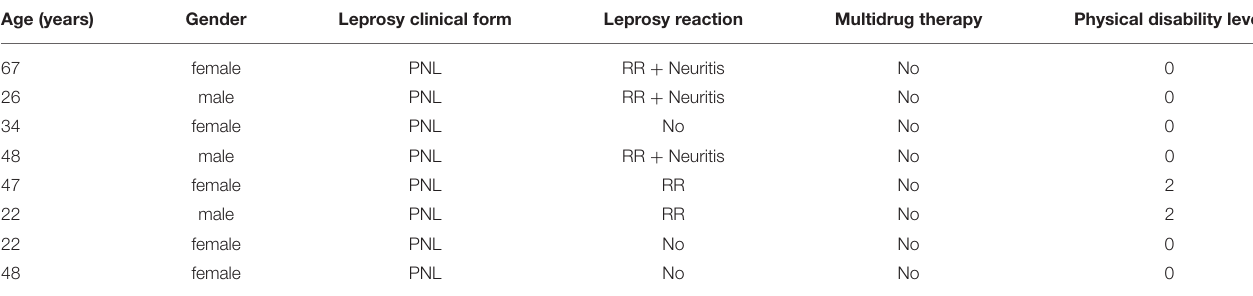
TABLE 1 | Clinical data from PNL patients included in the present study ( n =